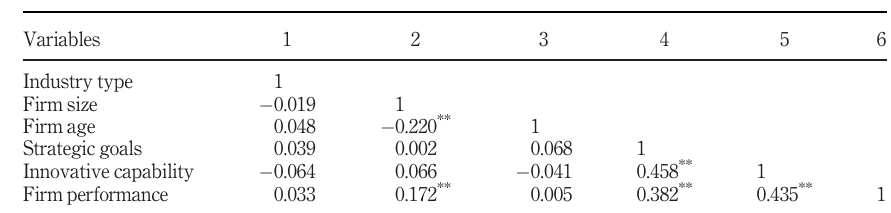
Table III. Descriptive